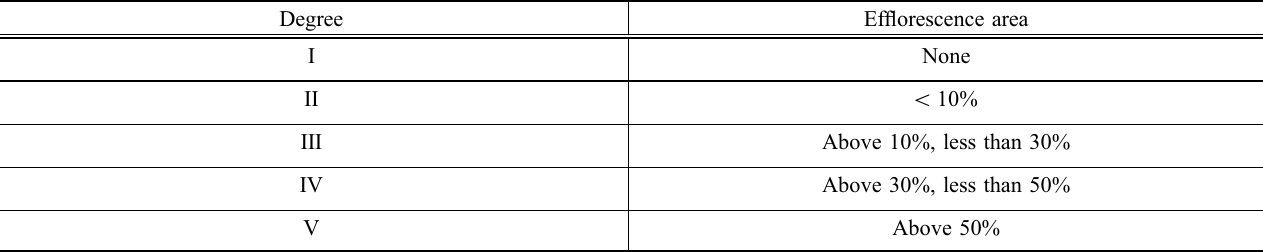
Table 5 Quantification of efflorescence